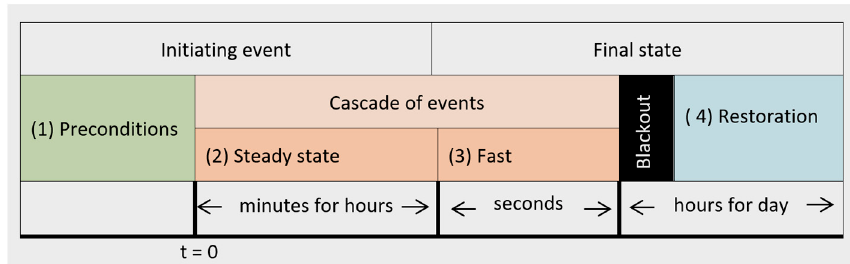
Figure 3. Phase-by-phase progression of a blackout.